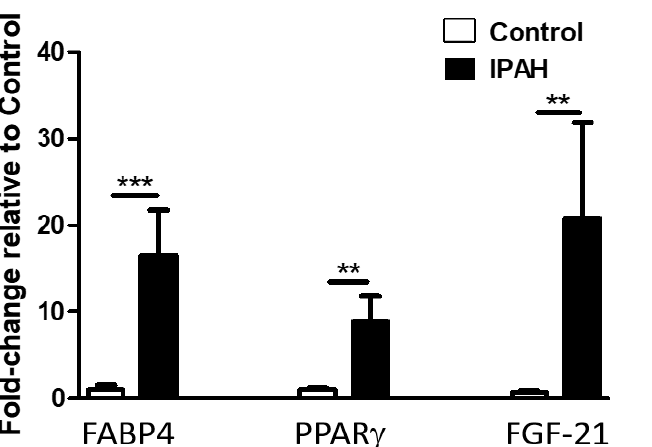
Figure 2. Increased Lung levels of FABP-4, peroxisome proliferator-activated receptor γ (PPAR γ ), and FGF-21 mRNA in human IPAH compared to controls. Data represent mean ± SEM from n = 15–22 patients per group (see Table S1 and S2 for patient characteristics). Statistical analysis by Student’s